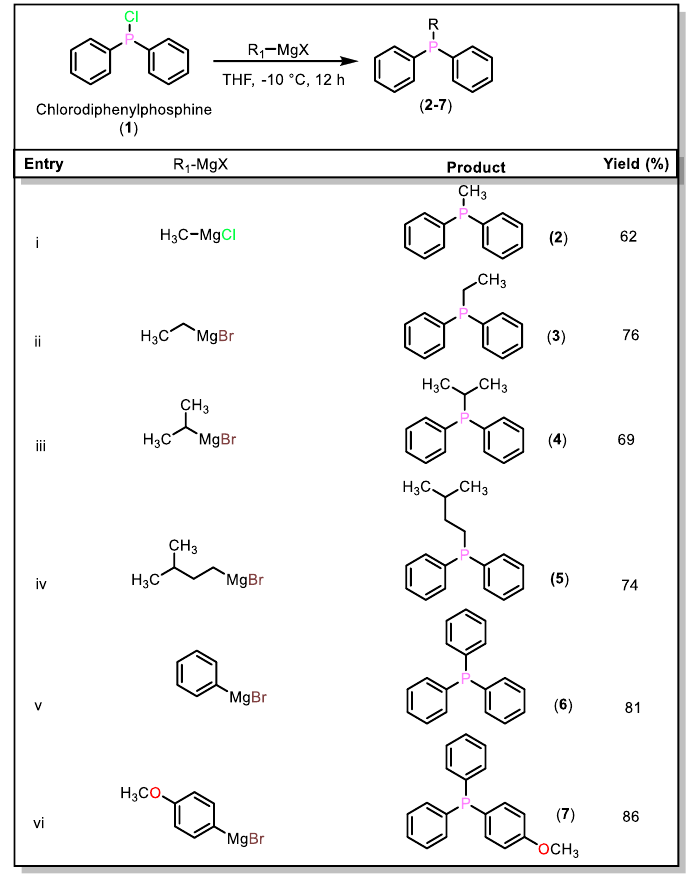
Figure 1. Synthesis of mixed arylalkyl and triaryl phosphines starting from chlorodiphenylphosphine.